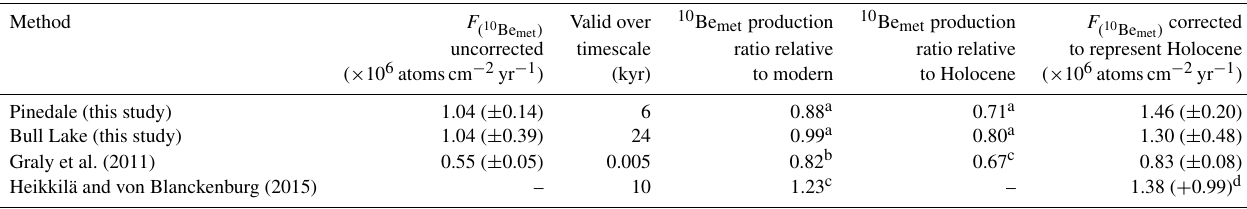
Table 3. 10 Be met flux estimates, raw and normalized for Holocene paleointensity variations.